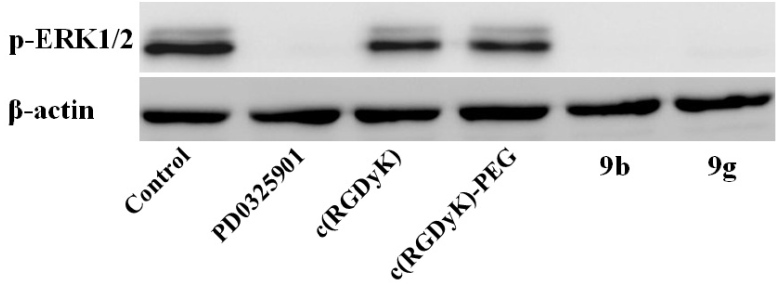
Figure 3. Western blotting analyses of melanoma A375 cells lysates were performed for p-ERK1/2 after 2h. Β -actin served as loading control. Cells were treated with 10 μ M of PD0325901 , c(RGDyK) peptides, and RGD-MEKI conjugates 9b and 9g